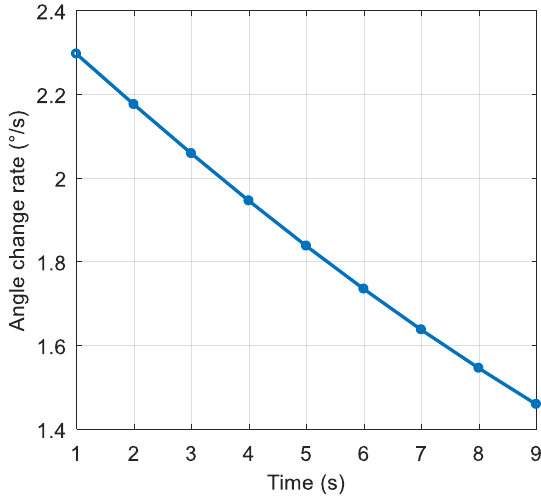
Figure 9. The rate of change of the interference arrival angle.